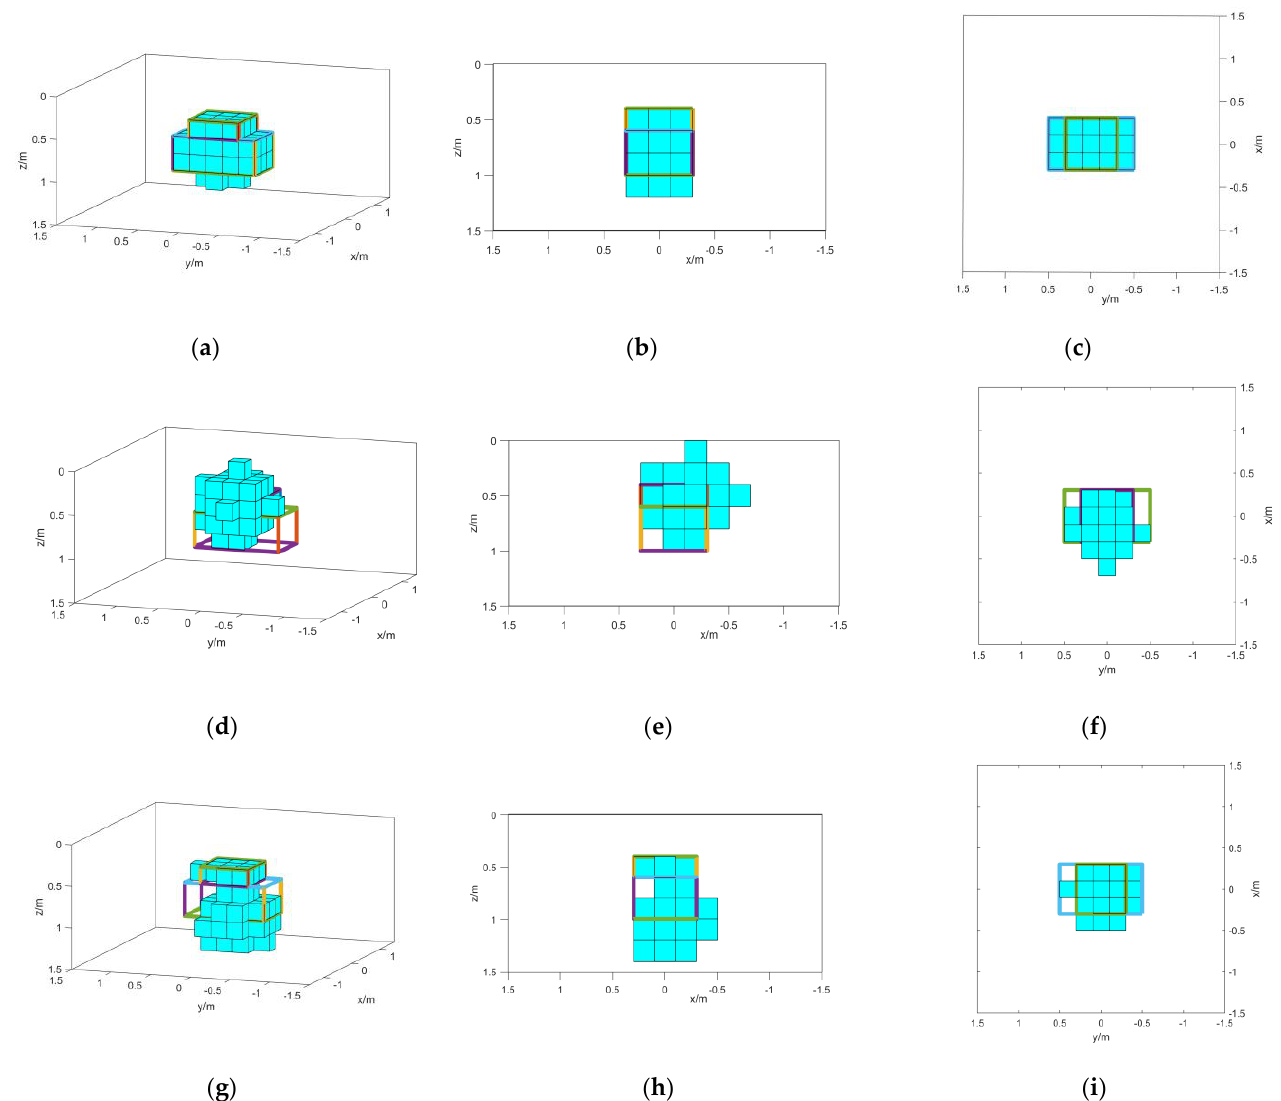
Figure 12. ( a ) Method 1 inversion results; (b) left- side view of method 1 inversion results; (c) top view of method 1 inversion results; (d) method 2 inversion results; (e) left- side view of method 2 inversion results; (f) top view of method 2 inversion results; (g) method 3 inversion results; (h) left- side view of method 3 inversion results; (i) top view of method 3 inversion results.